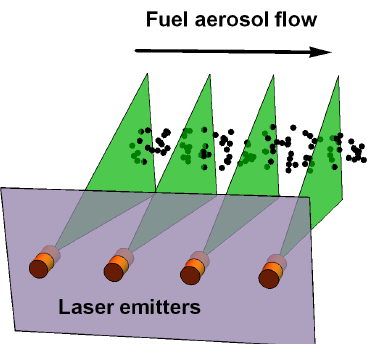
Figure 5. The sequential application of the laser processing for a flow of fuel aerosol from a usual injection